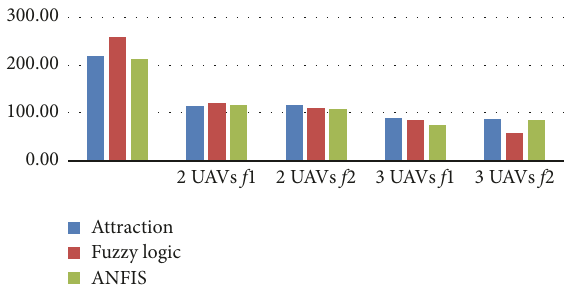
Figure 24: La Palma path planning mean time for all the configura- tions and every